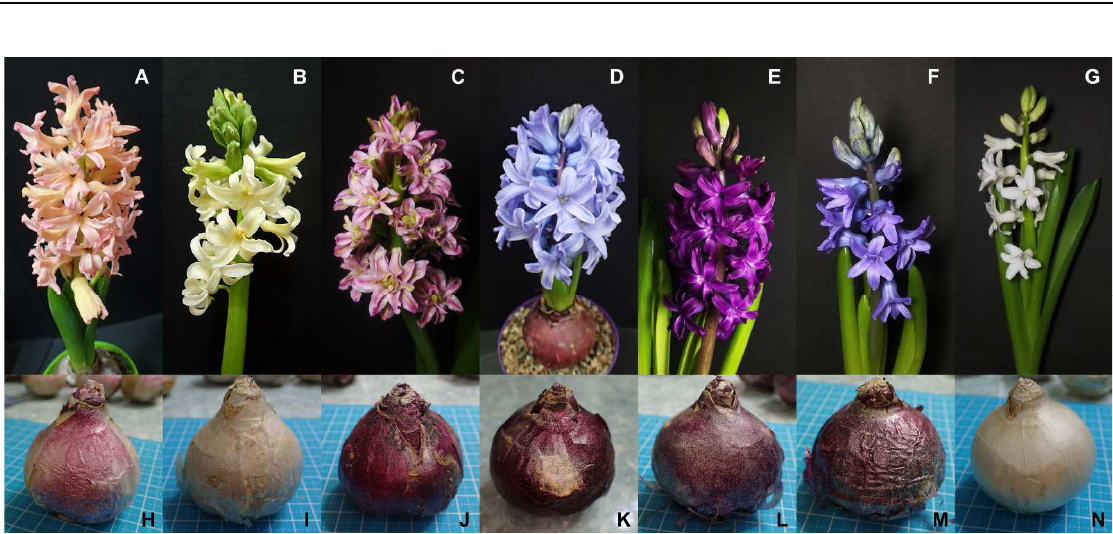
Figure 2. Inflorescences and tunicate bulbs of the seven Hyacinthus cultivars. ( A – G ) Inflorescences. ( H – N ) Tunicate bulbs. ( A , H ) ‘Gipsy Queen’. ( B , I ) ‘City of Haarlem’. ( C , J ) ‘Eros’. ( D , K ) ‘Chicago’. ( E , L ) ‘Woodstocks’. ( F , M ) ‘Delft Blue’. ( G , N ) ‘Aiolos’. A paired-end library with an insert-size of 150 bp was constructed and sequenced on the NovaSeq 6000 platform (Illumina Inc. San Diego, CA, USA). CLC Genomic Work- bench version 21.0.4 (CLC Inc., Aarhus, Denmark) was used for the chloroplast genome according to the instructions of the manufacturer. The concentration of extracted assembly. About 3 GB raw reads of each specimen were firstly paired up and quality